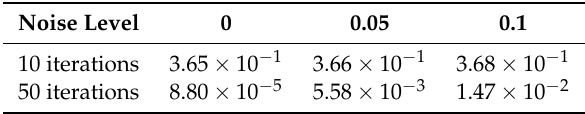
Table 1. The residual value ( Res ) depending on the stopping criterion and noise